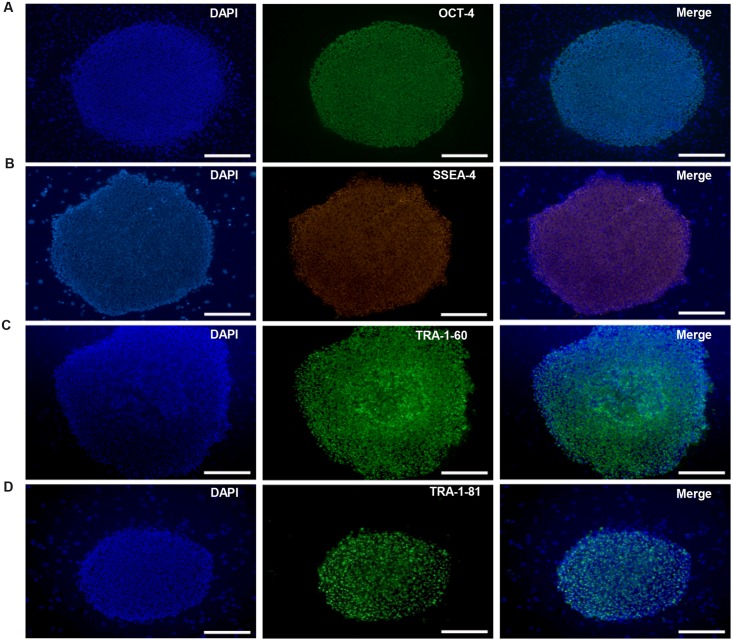
Immunocytochemical analysis of P96 cell line at passage 38. Immunofluorescence staining of undifferentiated P96 cells using OCT-4 (A), SSEA-4 (B), TRA-1-60 (C), and TRA-1-81 (D). Scale bars = 200 μm.